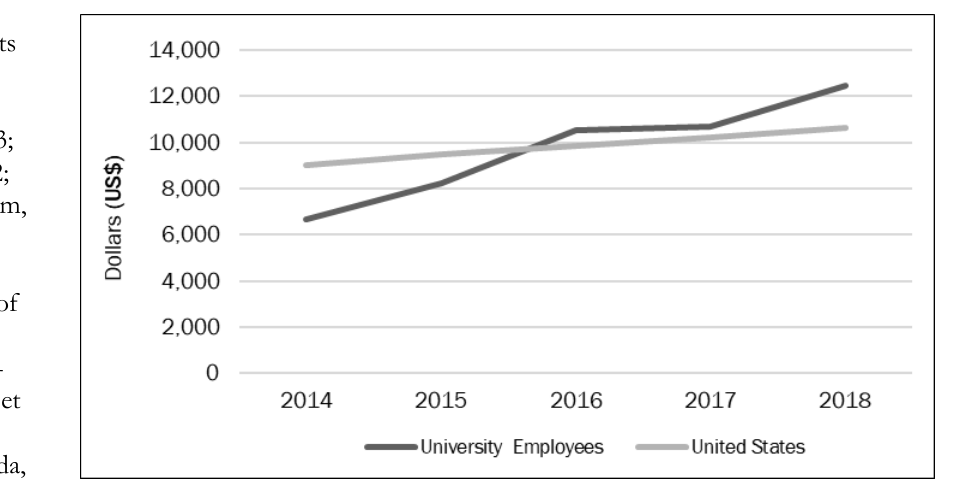
Figure 1. Per Capita Annual Billed Medical Claims: Comparison